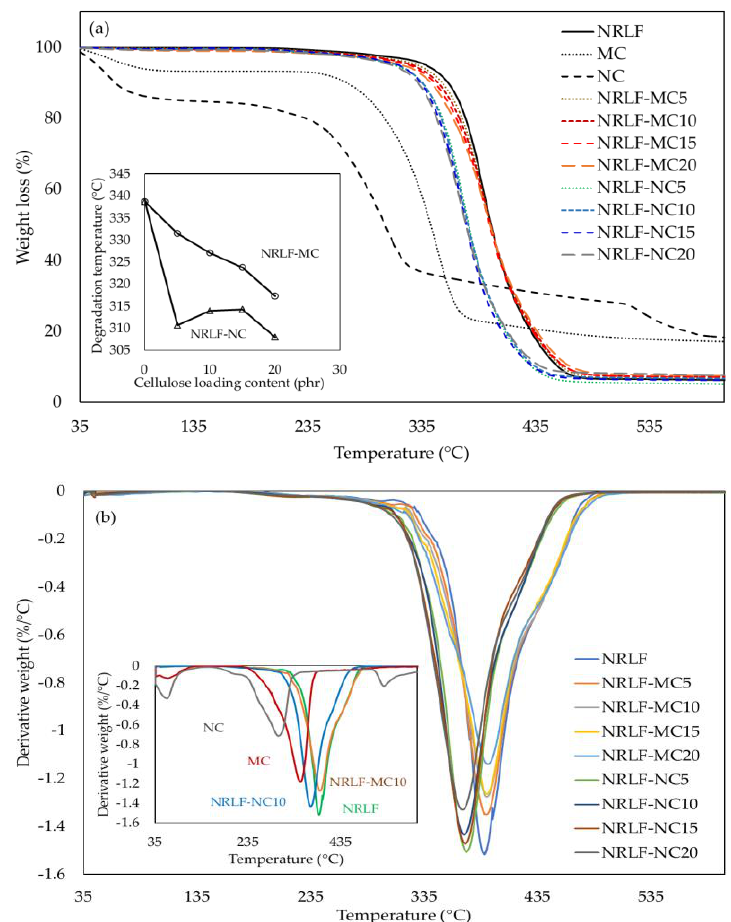
Figure 10. TGA ( a ) and DTG ( b ) curves for the degradation of NRLF, MC, NC, NRLF-MC and Figure 10. TGA (a) and DTG (b) curves for the degradation of NRLF, MC, NC, NRLF-MC and 436 NRLF-NC. 437